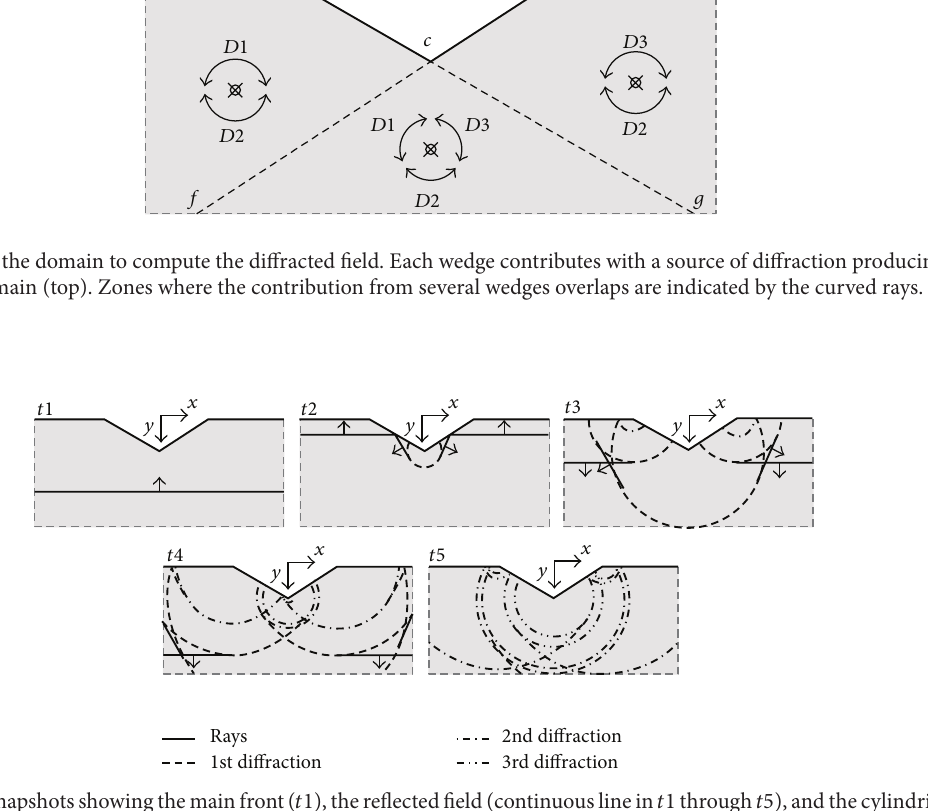
Figure 7: Schematic snapshots showing the main front ( 𝑡1 ), the reflected field (continuous line in 𝑡1 through 𝑡5 ), and the cylindrical diffracted waves up to 3rd order ( 𝑡2 through 𝑡5 ). At 𝑡2 the incident front is first order diffracted by point 𝑐 . Subsequently this same front experiences first-order diffraction by points 𝑏 and 𝑑 at 𝑡3 , while the initially formed cylindrical front experiences second-order diffraction at these points. Similarly, a third-order diffraction event produced by point 𝑐 is identified in 𝑡5